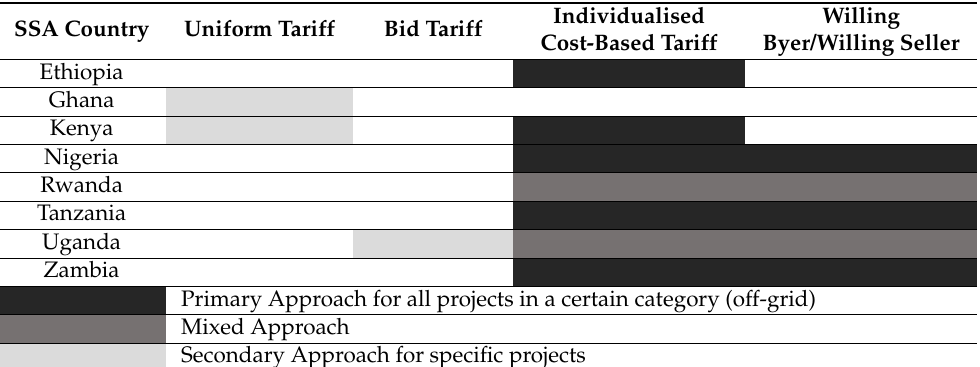
Table 1. Energy tariff-setting approaches for MGs in selected African countries (compilation based on: (NARUC: National Association of Regulatory Utility Commissioners,